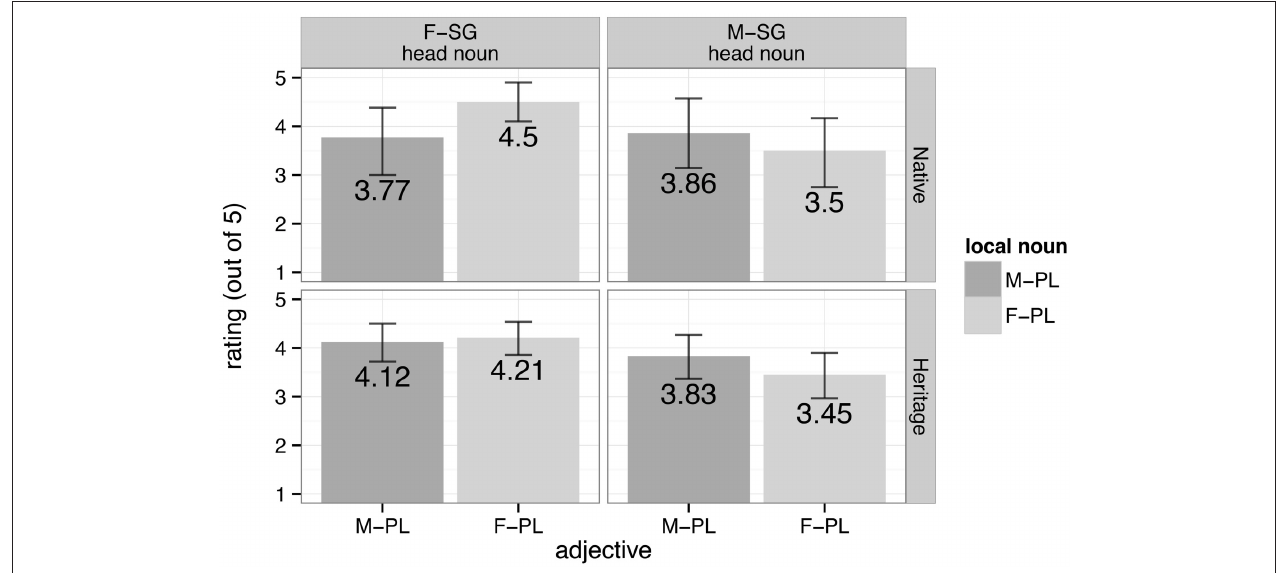
FIGURE 2 | Average ratings for potential attraction conditions from native (top) and heritage (bottom) speakers of Spanish in an extension of the methodology from Fuchs et al. (in